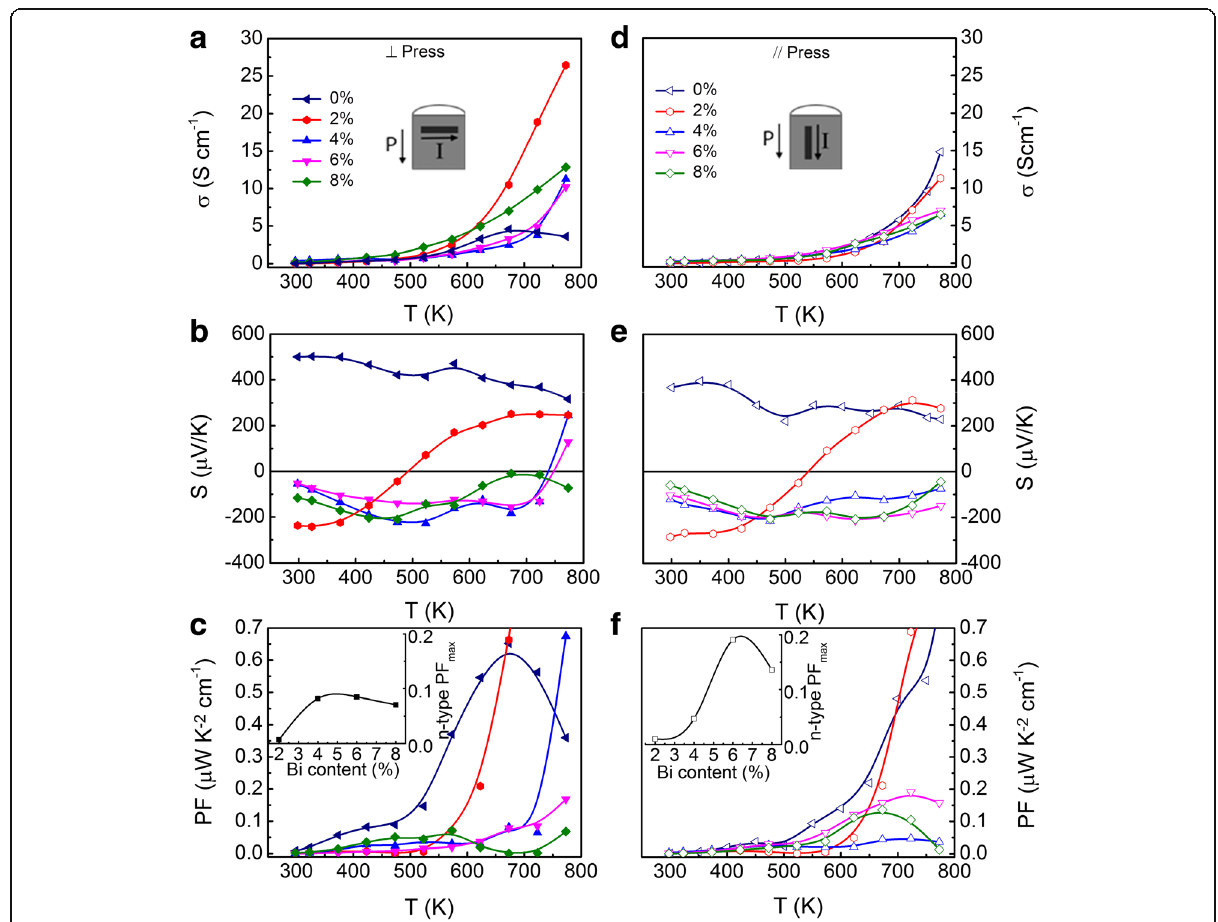
Fig. 3 (Color online) Temperature dependence of the electrical conductivity ( a , d ), Seebeck coefficient ( b , e ), and power factor ( c , f ) of samples with various Bi contents along ⊥ and // directions as defined in the inset of a and d , where the black arrows indicated the press direction P. The n-type maximum power factor as a function of Bi content is shown in the inset of c and